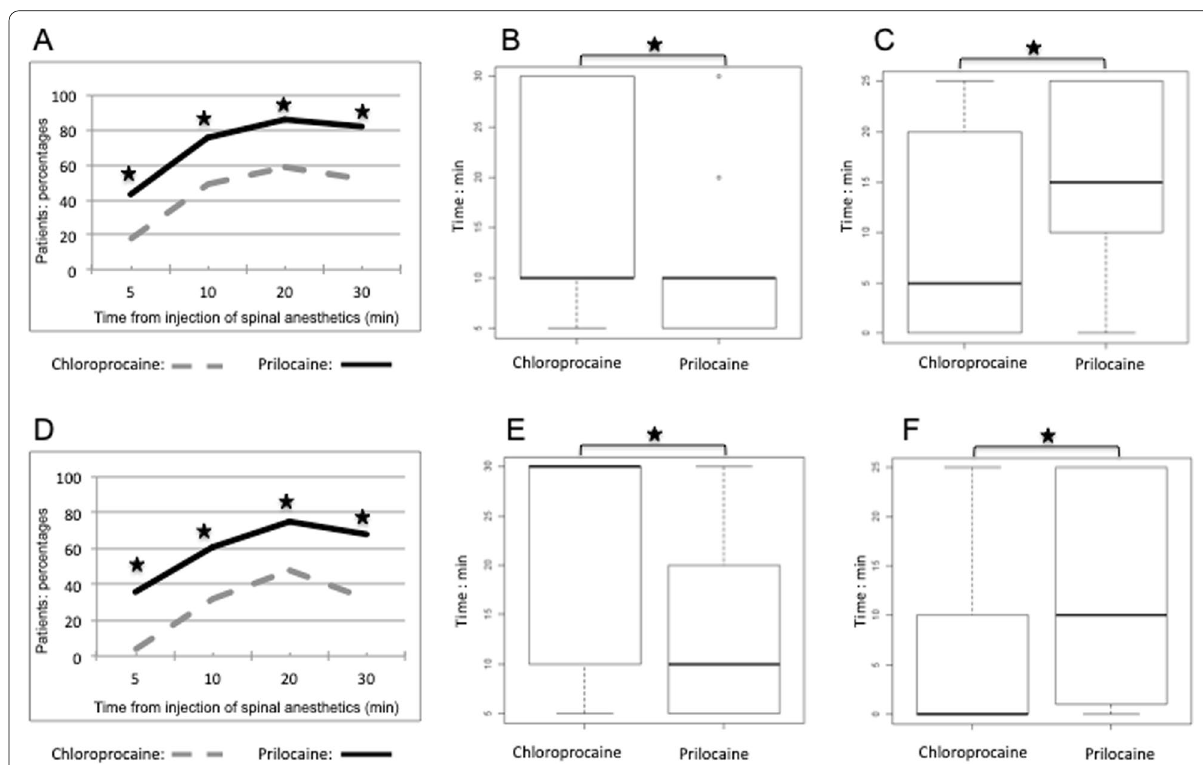
Fig. 3 a Percentage of patients with a complete loss of cold sensation at T10 dermatome during the first 30 min after local anesthetics injection. b Time to obtain a T10 dermatome level extension of sensory block evaluated with cold test. c Duration of sensory block at T10 dermatome level evaluated with cold test. d Percentage of patients with negative pin-prick test at T10 dermatome during the first 30 min after local anesthetics injection. e Time to ontain a T10 dermatome level extension of sensory block evaluated with pin-prick test. f Duration of sensory block at T10 dermatome level evaluated with pin-prick test. Statistically significant differences are marked with *( P < 0.05)